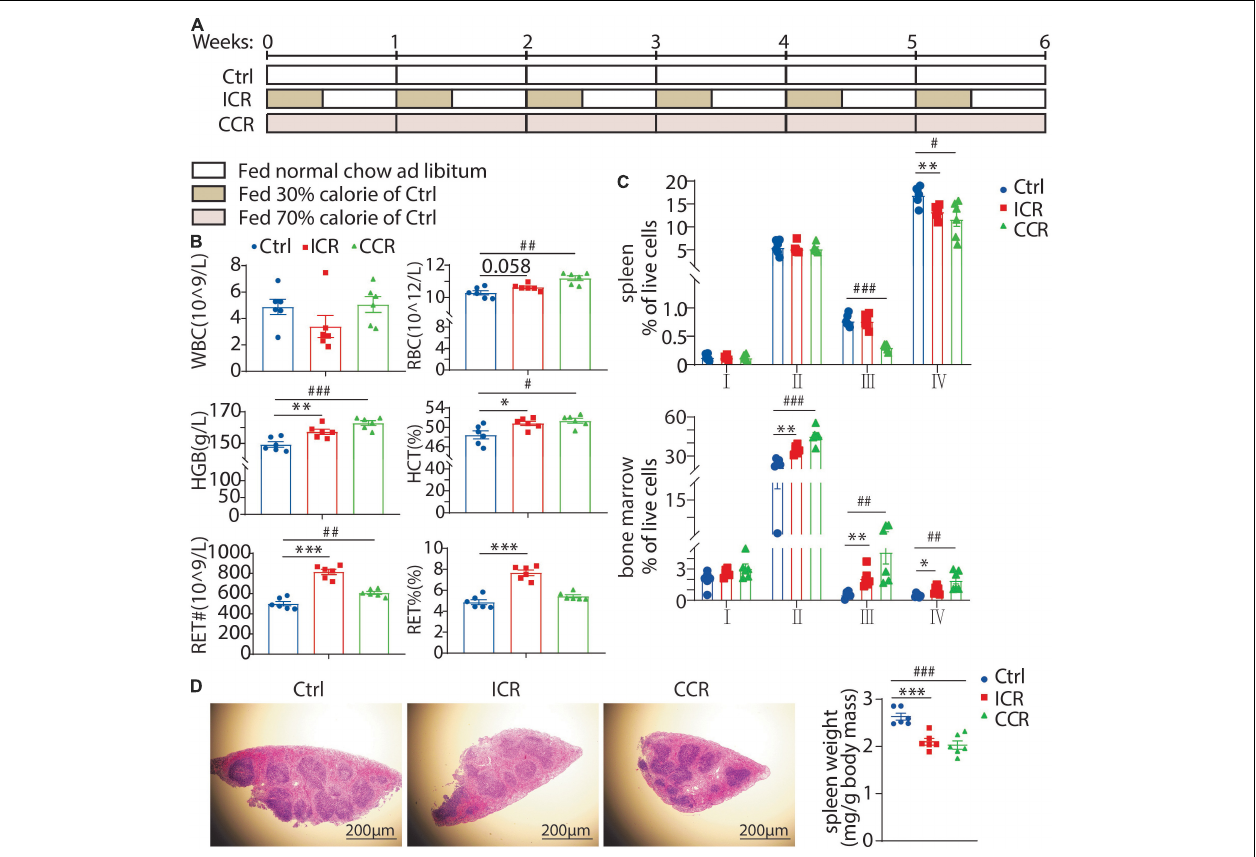
FIGURE 3 | Effect of a long-term CR on erythrocyte development in mice. (A) Design of the experiment. Seven-week-old male C57BL/6 mice were divided into three groups ( n = 6 for each group). (B) Blood count of the mice using peripheral blood. (C) The proportion of erythroid cells at different stages in the spleen and bone marrow. (D) Representative images of H&E staining of the spleen with its weight shown in the right panel. Scale bars: 200 µ m. All the data are presented as mean ± S.E.M. ∗ P < 0.05, ∗∗ P < 0.01, ∗∗∗ P < 0.001 for difference between control and intermittent CR groups. # P < 0.05, ## P < 0.01, ### P < 0.001 for difference between control and continuous CR